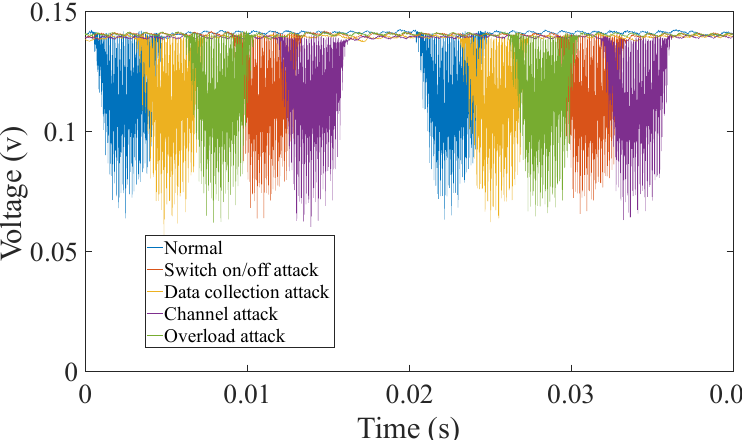
Figure 3. The power traces in the time domain of Distribution Terminal Unit (DTU) under different attacks. The running cycles of each program are the same, but the amplitudes of power are slightly different.